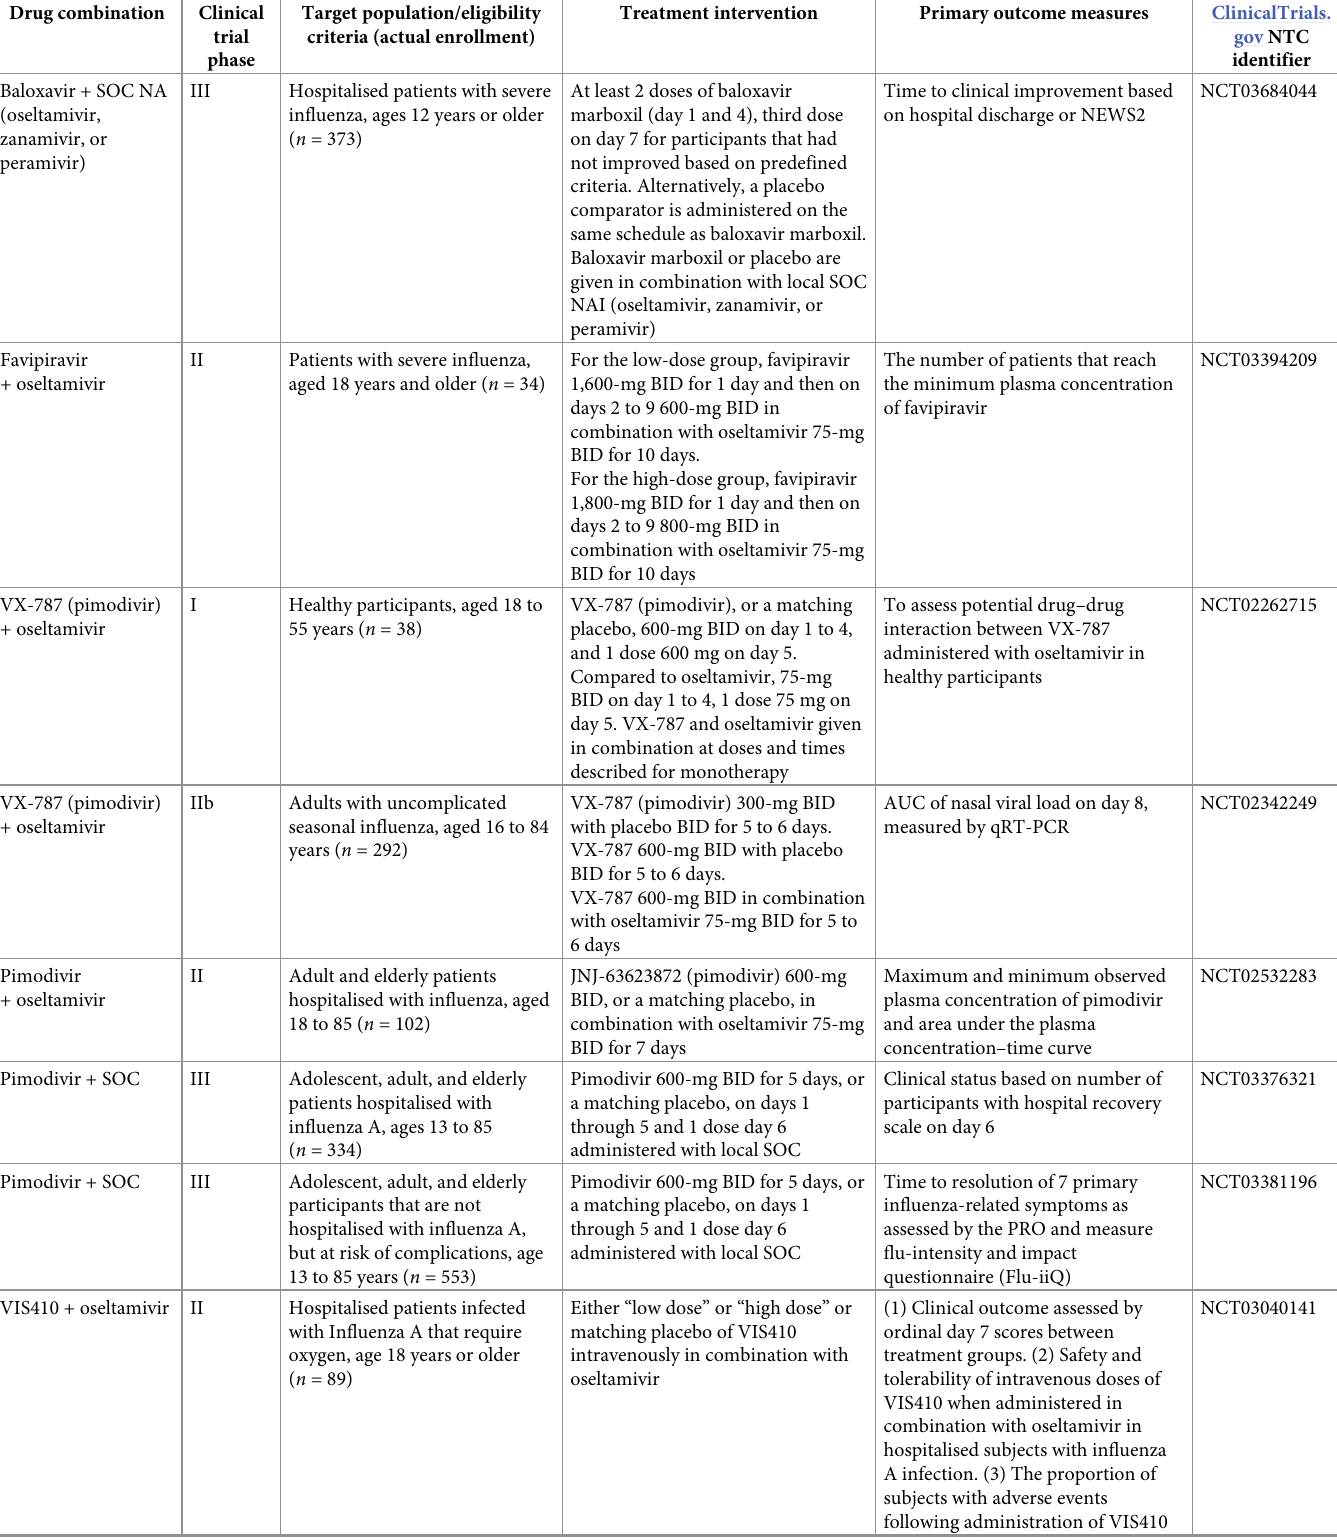
Table 2. Clinical trials with antiviral or other drugs used in combination for the treatment of